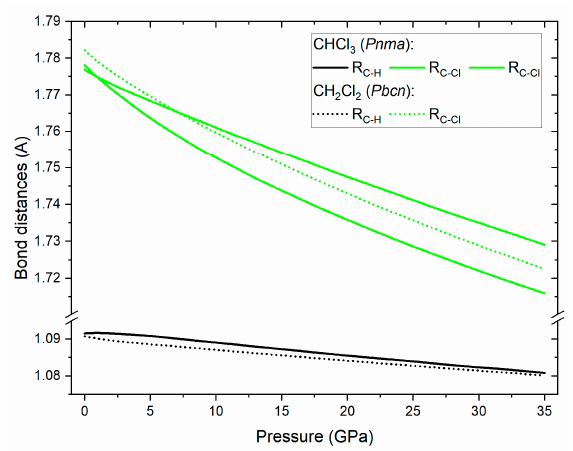
Figure 4. Simulated dependence of the C-H (black lines) and C-Cl (green lines) bond lengths in CHCl 3 in the Pnma structure (full lines) and CH 2 Cl 2 in the Pbcn structure (dotted lines).